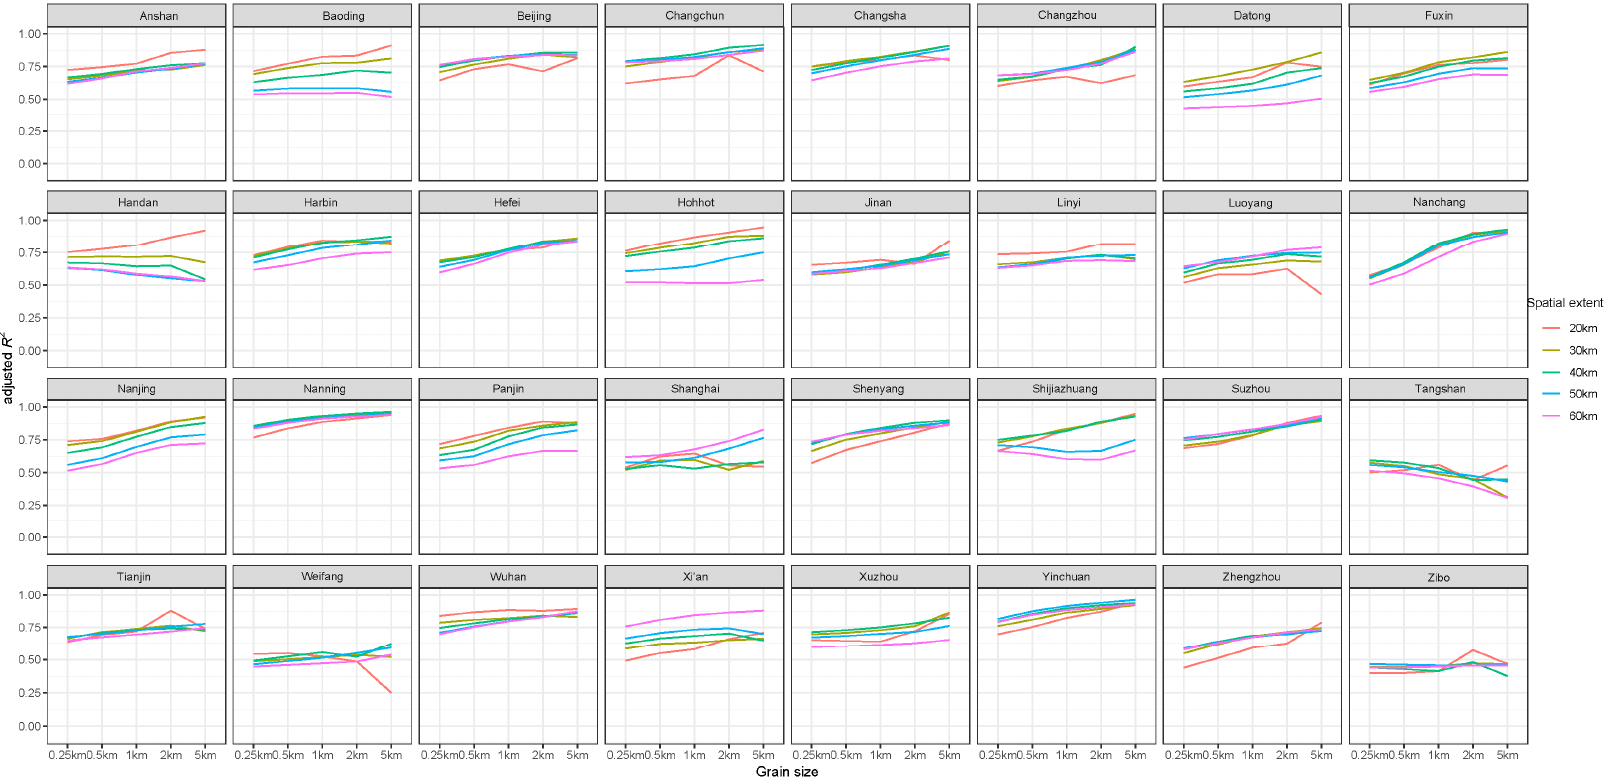
Figure A8. Collective explanatory power for explaning LST(Scalogram of the grain size).